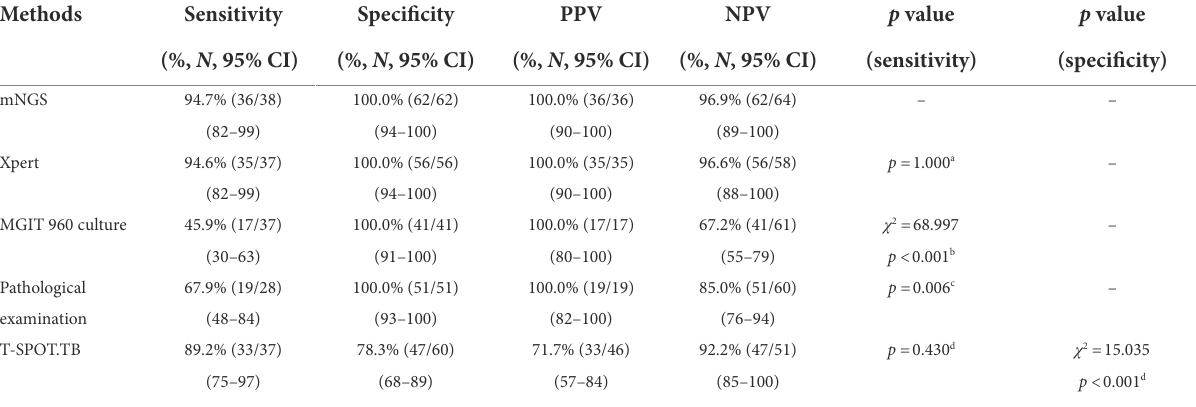
TABLE 3 Performance of mNGS and conventional detection methods in patients with spinal TB. Methods